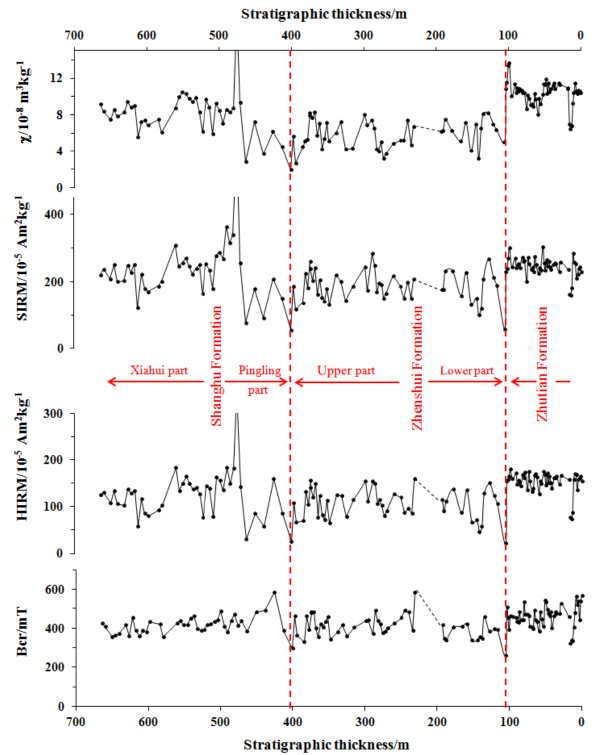
Figure 4. Magnetic parameter variations of the Datang profile; the x axis indicates the stratigraphic thickness from the Zhutian Forma- tion to the Shanghu Formation.